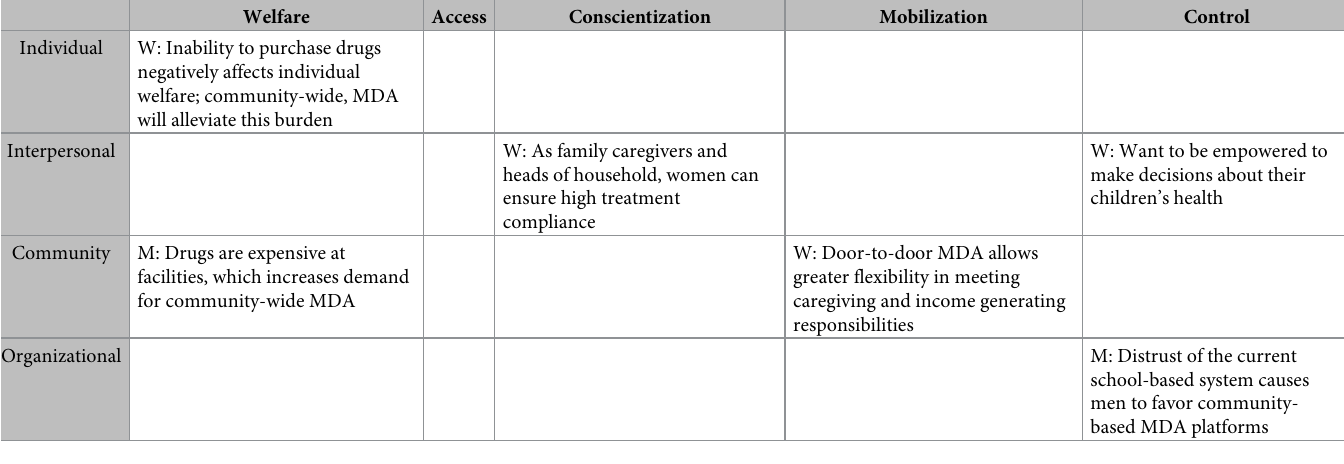
Table 2. Summary of facilitators towards participating in the MDA broken down by gender. Welfare